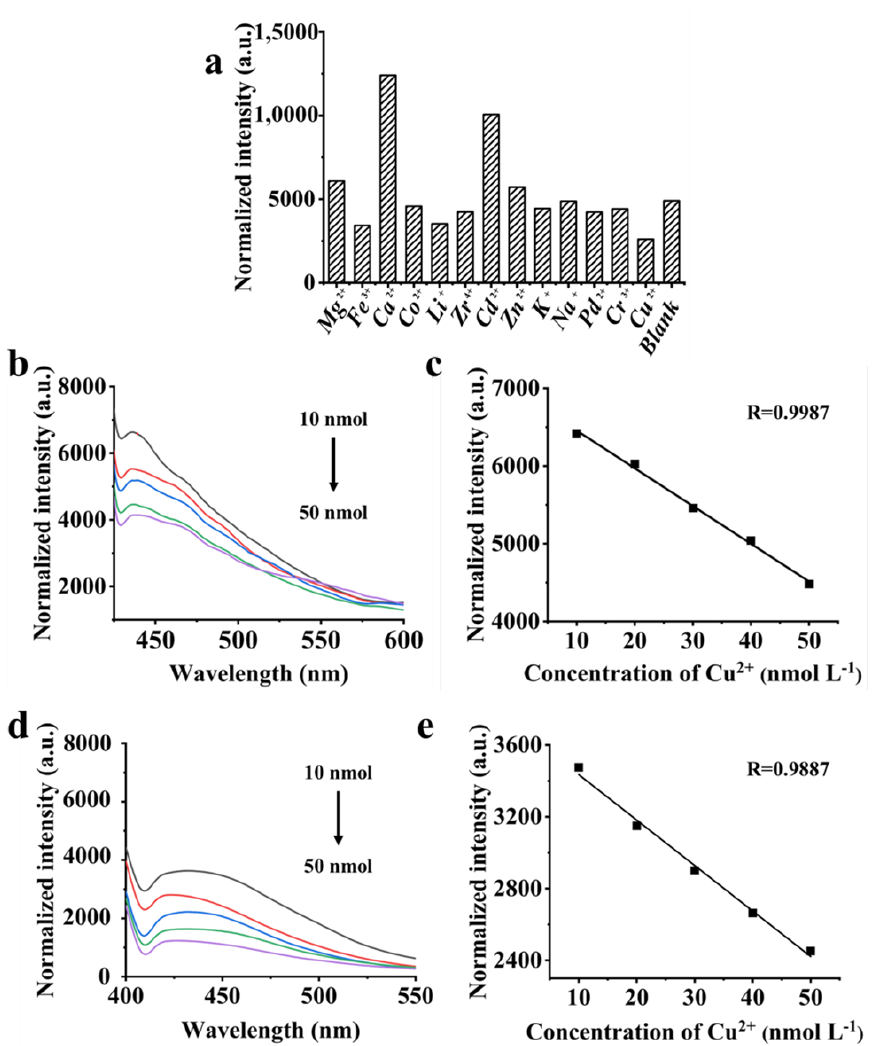
Figure 6. ( a ) Fluorescence intensity of AC-12@CD with 13 kinds of metal ions, ( b ) fluorescence emission spectrum of AC-4@CD containing different concentrations of Cu 2+ , ( c ) linear response curve of AC-4@CD for detection of Cu 2+ , ( d ) fluorescence emission spectrum of AC-12@CD containing different concentrations of Cu 2+ , ( e ) linear response curve of AC-12@CD for detection of Cu 2+.